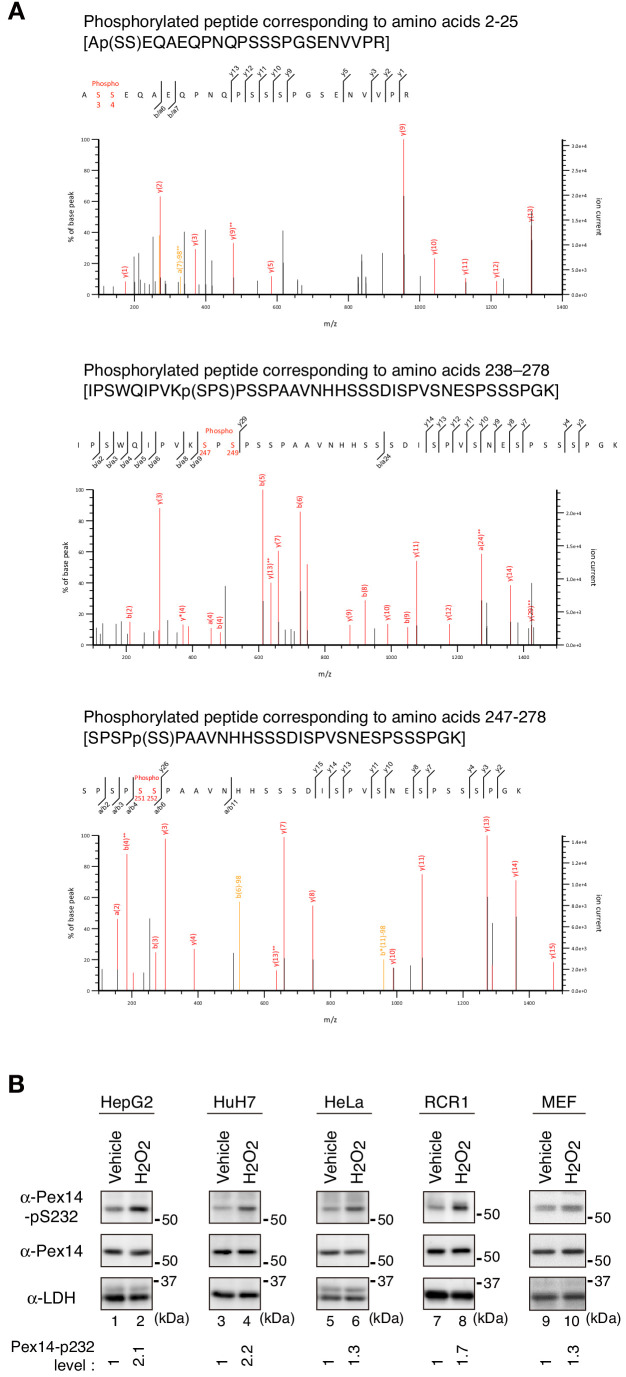
H2O2-induced phosphorylation of Pex14: identification the phosphorylation sites by LC-MS/MS analysis and detection of Pex14-pS232 in various cultured cell lines.(A) LC-MS/MS analysis for phosphorylation sites of Pex14 upon H2O2 treatment was performed as in Figure 2B. Fragment spectra of phosphorylated peptides corresponding to amino acids 2–25 containing pS3 or pS4 (upper panel), amino acids 238–278 containing pS247 (middle panel), and amino acids 247–278 containing pS252 (lower panel) are shown. (B) Phosphorylation of Pex14 at Ser232 was induced in various cultured cells upon H2O2-treatment. Several mammalian cell lines (4 × 105 cells each) were treated with vehicle and 0.5 mM H2O2 for 0.5 hr (HepG2, HuH7, and MEF) and 1 hr (HeLa and RCR1), similarly to Figure 1B, and were analyzed by SDS-PAGE and immunoblotting with indicated antibodies. The levels of Pex14 phosphorylation at Ser232 upon H2O2-treatment were quantified, normalized by that of total Pex14, and represented at the bottom by taking as one those in vehicle-treated cells.